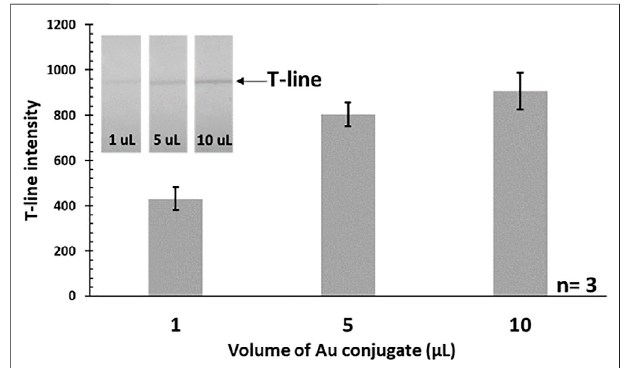
FIGURE 1 | Effect of the used Au-antibody conjugate ’ s volume on the T-lineintensity(IL-6 (cid:1) 100 pg/mL).Actualphotographofpaperstripsisshown in the